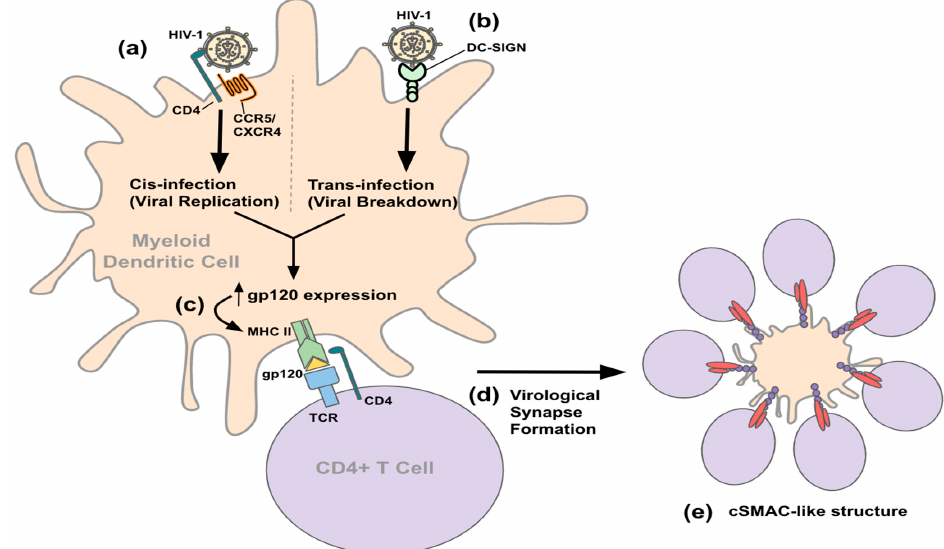
Figure 1. HIV-1 interaction with mDC. ( a ) HIV-1 binds the CD4 receptor and corresponding coreceptor (CCR5/CXCR4) on the DC cell surface, inducing internalization of the virus, viral replication, and cis-infection where the DC itself becomes infected with HIV. ( b ) HIV-1 binds the DC-SIGN receptor on the DC cell surface leading to viral breakdown and trans-infection where the DC merely processes HIV-1 and presents particles to other immune cells. ( c ) Both cis- and trans-infection lead to increased HIV-1 gp120 protein expression on MHC class II surface receptors. The DC MHC II receptor presenting gp120 binds to TCR and CD4 receptors on the T cell surface. ( d ) Increased gp120 expression induces virological synapse formation that resembles the cSMAC structure that is seen in immunologic synapses. ( e ) The cSMAC-like structure is composed of a DC that is surrounded by a ring of CD4 + T cells. The cells are connected via ICAM-1/LFA-1 interactions where ICAM-1 is expressed on the DC and LFA-1 is expressed on the T cell.